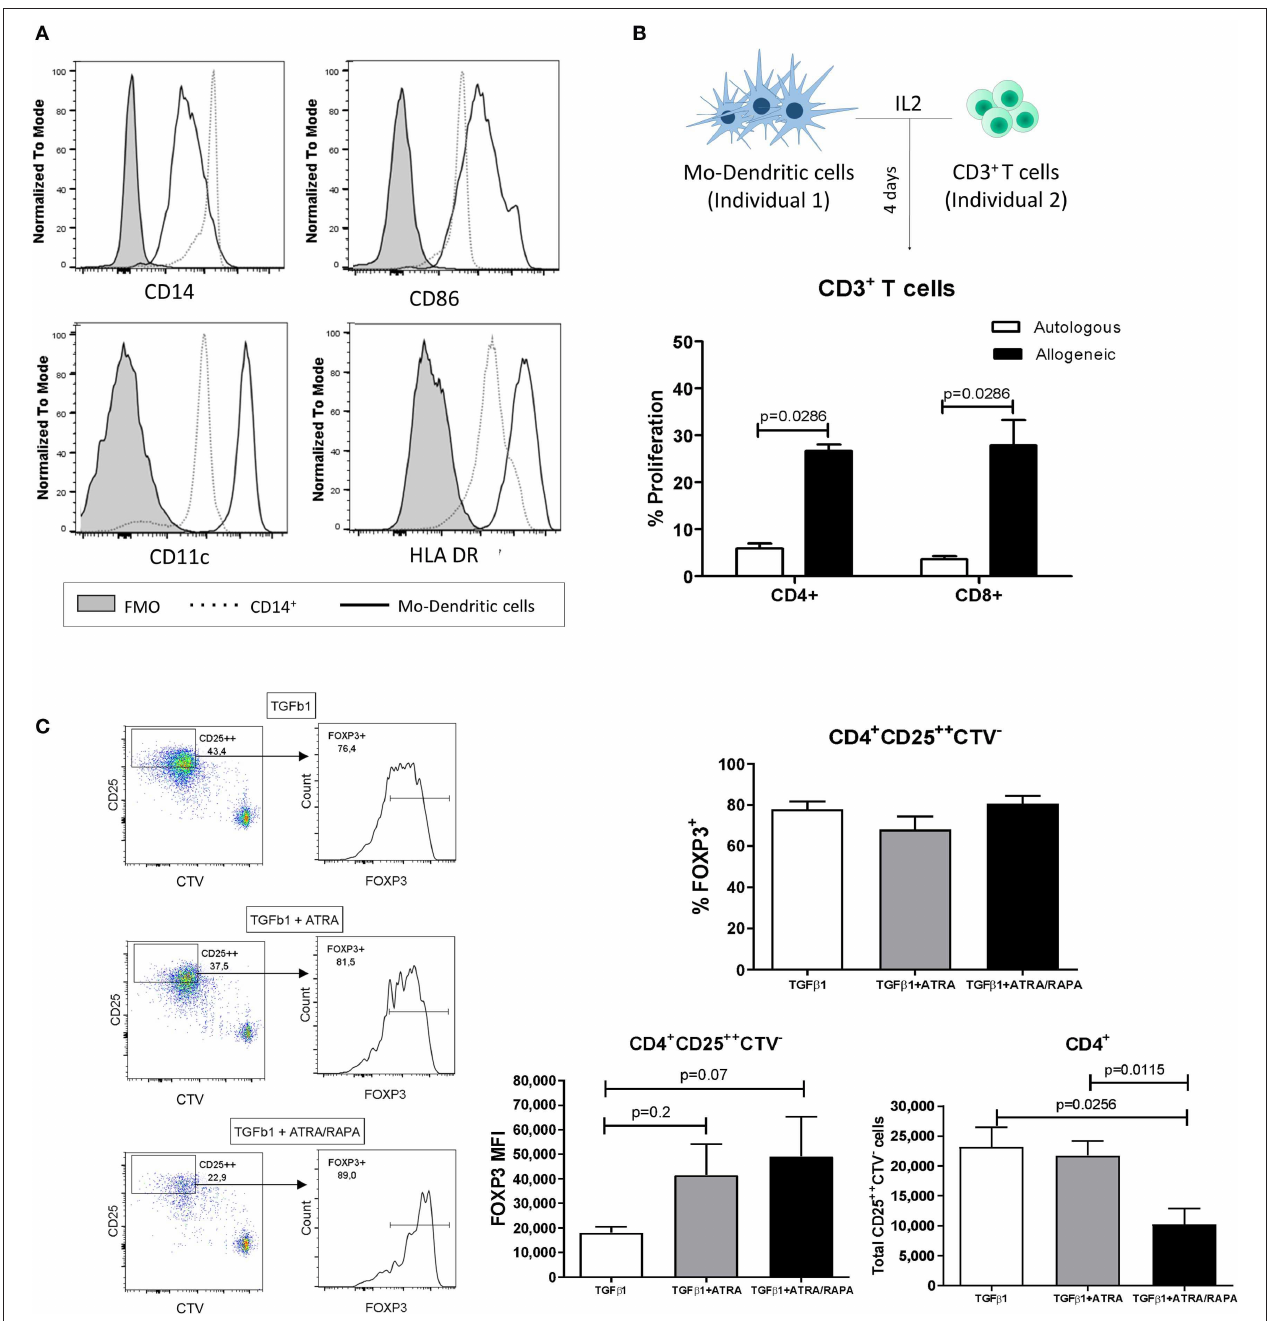
FIGURE 1 | Monocyte-derived dendritic cells generate de novo allospecific induced Tregs. Dendritic cells were derived from peripheral CD14 + monocytes with GM-CSF and IL-4 for 8 days. (A) Expression of representative markers on Mo-DCs was determined by flow cytometry. Mo-DCs express higher levels of CD86, CD11c, and HLA-DR compared to CD14 + monocytes. (B) Mo-DCs were able to induce CD4 + and CD8 + T cell proliferation in co-culture with T cells from unrelated individuals. (C) Mo-DCs were co-cultured with labeled CTV naïve T cells in the presence of TGF- β 1 and all-trans retinoic acid (ATRA) and/or rapamycin (RAPA). The great majority of proliferating CD4 + CD25 ++ CTV − cells from the co-culture between allogeneic Mo-DCs and naïve T cells express the transcription marker FOXP3 (left panels) in all conditions. Although the frequency of iTregs (identified as CD25 ++ FOXP3 + ) is similar among the three conditions evaluated (bar graph, upper right), the expression of FOXP3 [mean fluorescence intensity (MFI)] is slightly higher in the conditions with ATRA and/or RAPA. A greater number of cells are obtained in the co-cultures with TGF- β 1 + ATRA, from which CD4 + CD25 ++ CTV − cells can be sorted with greater efficiency to go on the subsequent assays (bar graphs, lower right). MFI values were calculated by subtracting the FMO (fluorescence minus one) control of the indicated antibody from the MFI value of each individual. Data represent the mean ± SEM from n = 5 donors from two independent experiments. The statistical analysis was performed using the non-parametric Mann–Whitney test, two-tailed. P < 0.05 was considered statistically